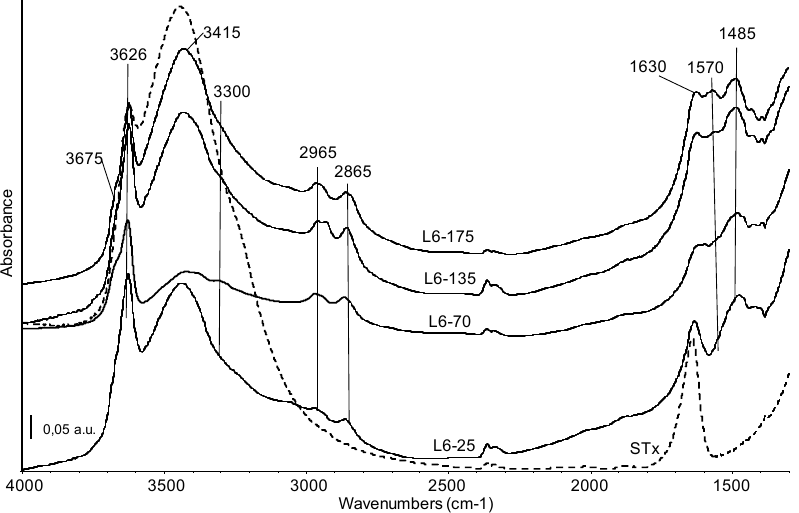
Figure 5. FT-IR skeletal spectra of the organo-clays prepared at different initial L6 amine content (common scale). Broken line: FT IR spectrum of the reference STx material.